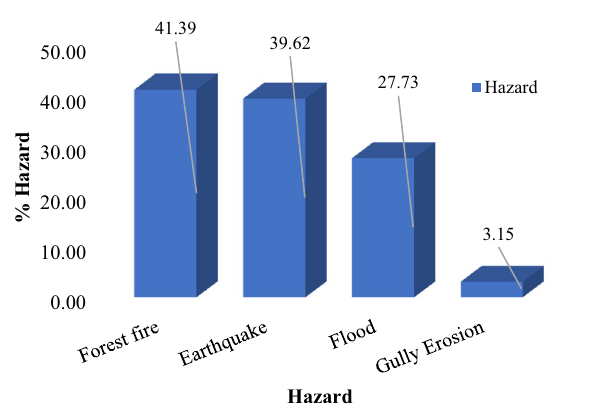
Figure 7. Percentage area of the four